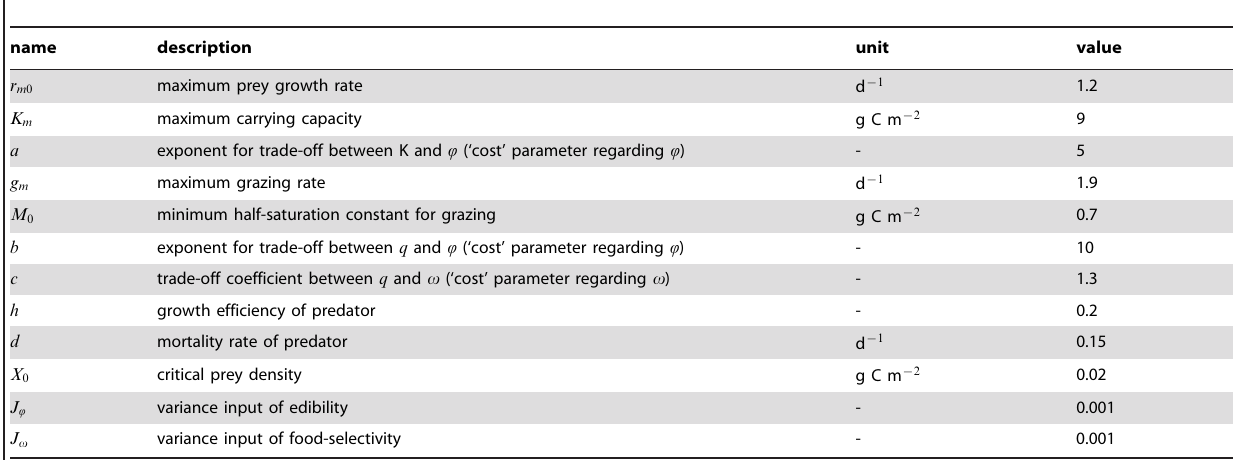
Table 1. Description and values of parameters used by the dynamic-trait